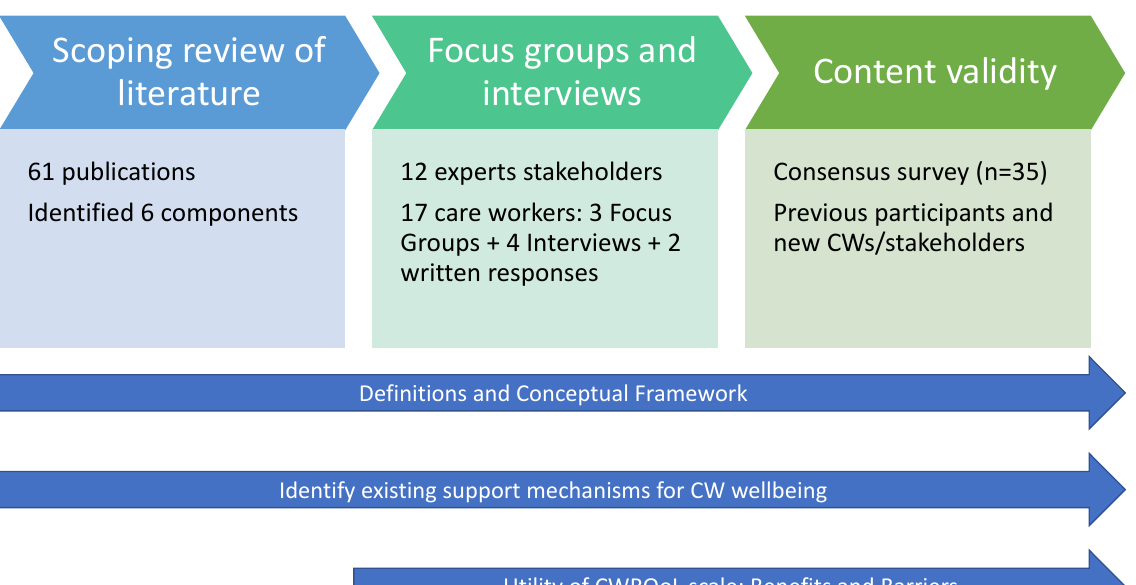
Figure 1. Summary of the Study Design and Participants.